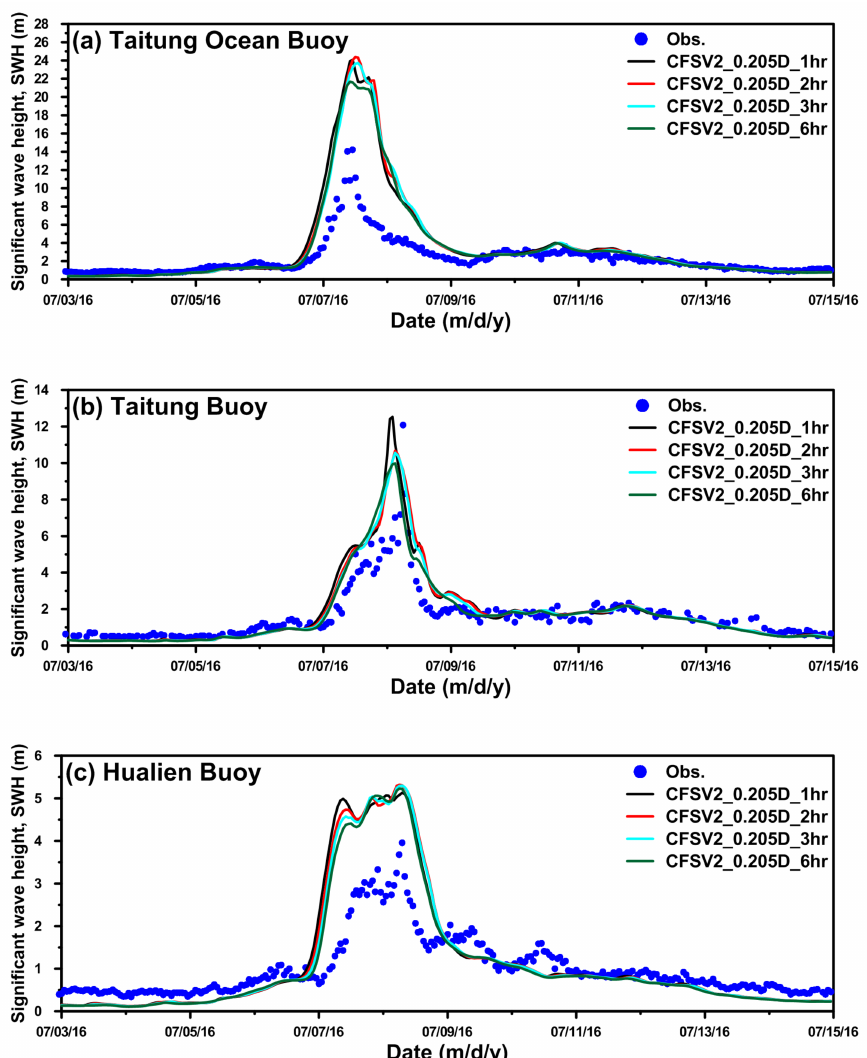
Figure 7. Model-data comparison for the SWH time series of the ( a ) Taitung Ocean, ( b ) Taitung, and ( c ) Hualien buoys employing the winds from CFSV2 with a spatial resolution of 0.205 ◦ and di ff erent temporal